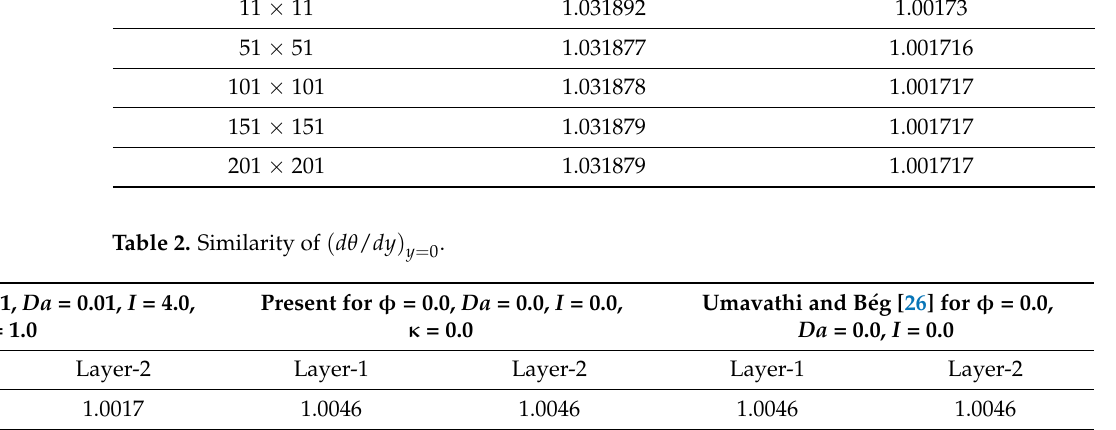
Table 1. Grid independence test using water as base fluid and copper as nanoparticle.